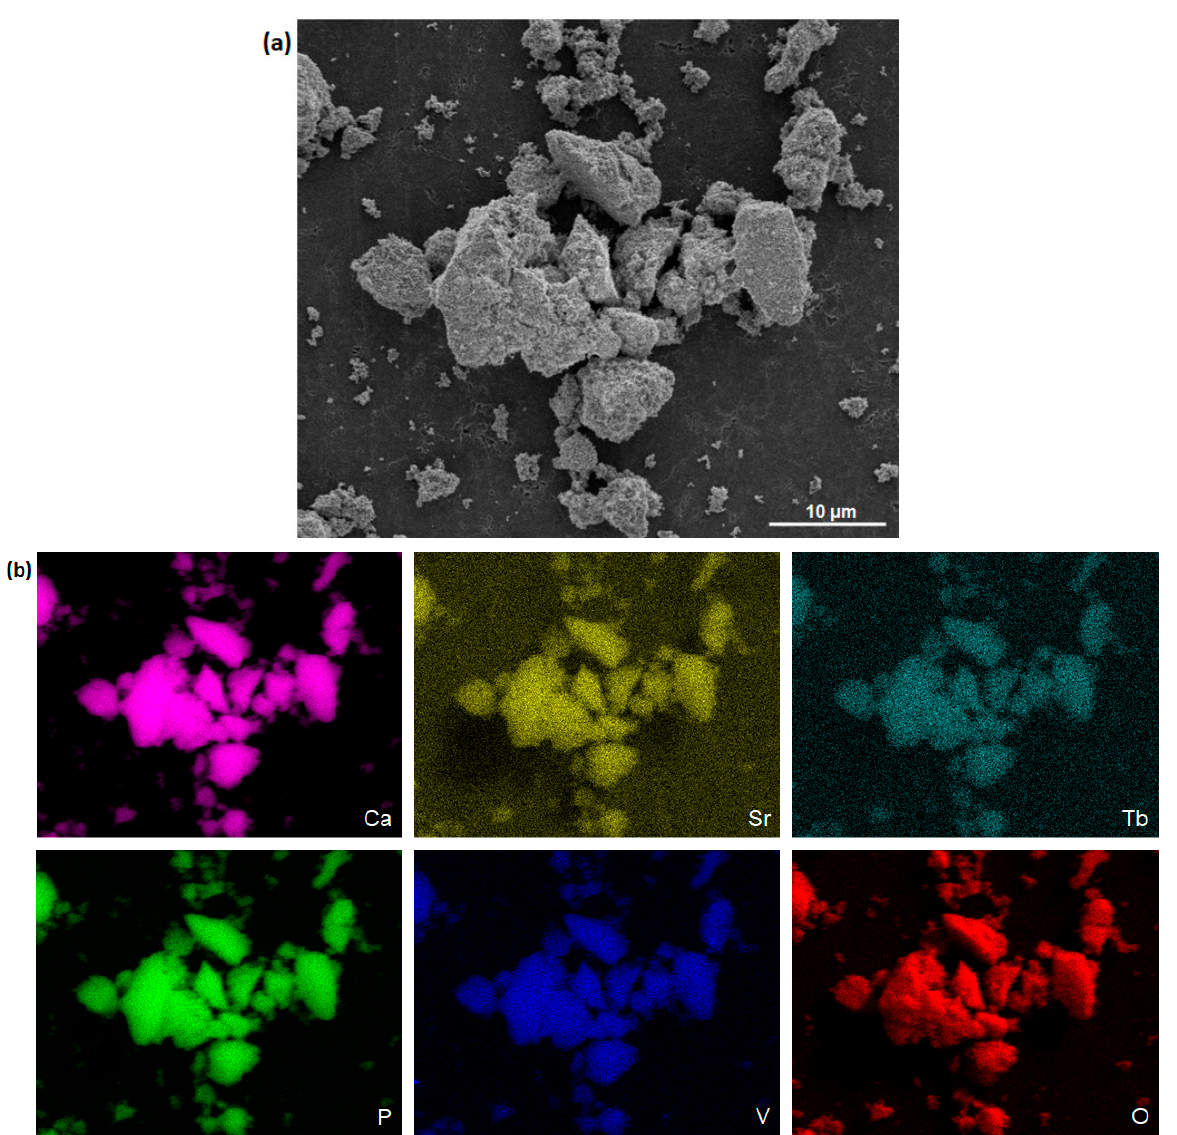
Figure 3. ( a ) SEM image of HVp co-doped with 1 mol% Sr 2+ and 1 mol% Tb 3+ annealed at 700 ◦ C. ( b ) SEM-EDS elemental mapping of HVp co-doped with 1 mol% Sr 2+ and 1 mol% Tb 3+ ions annealed at 700 ◦ C. Images show elemental composition of the sample, which contains calcium, strontium, terbium, phosphate, vanadium and oxygen elements. Table 1. The elemental contents in the obtained materials (annealed at 600 °C) measured with the ICP-OES technique.